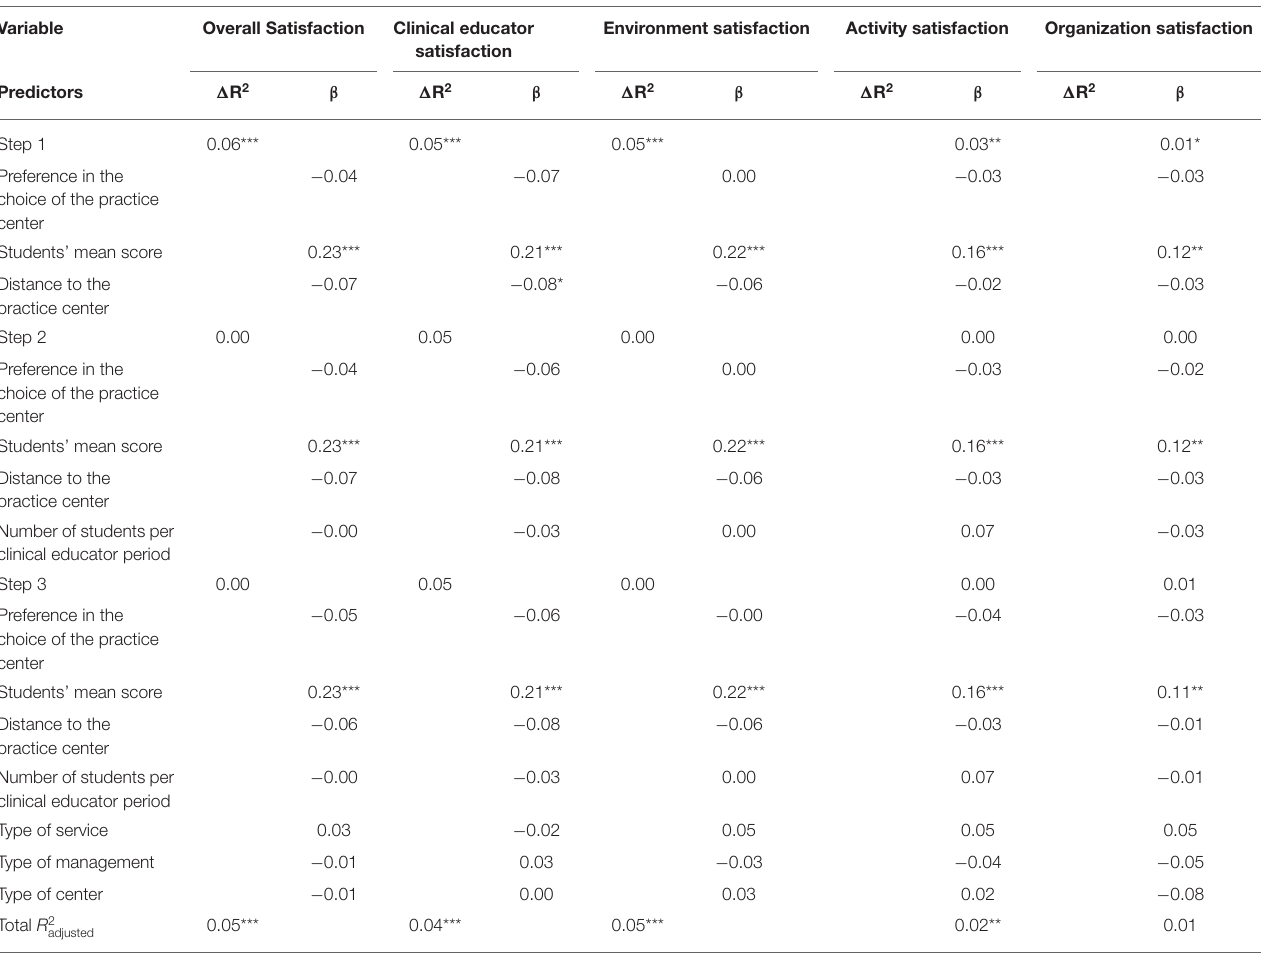
TABLE 3 | Hierarchical regression analysis with the satisfaction variable. Variable